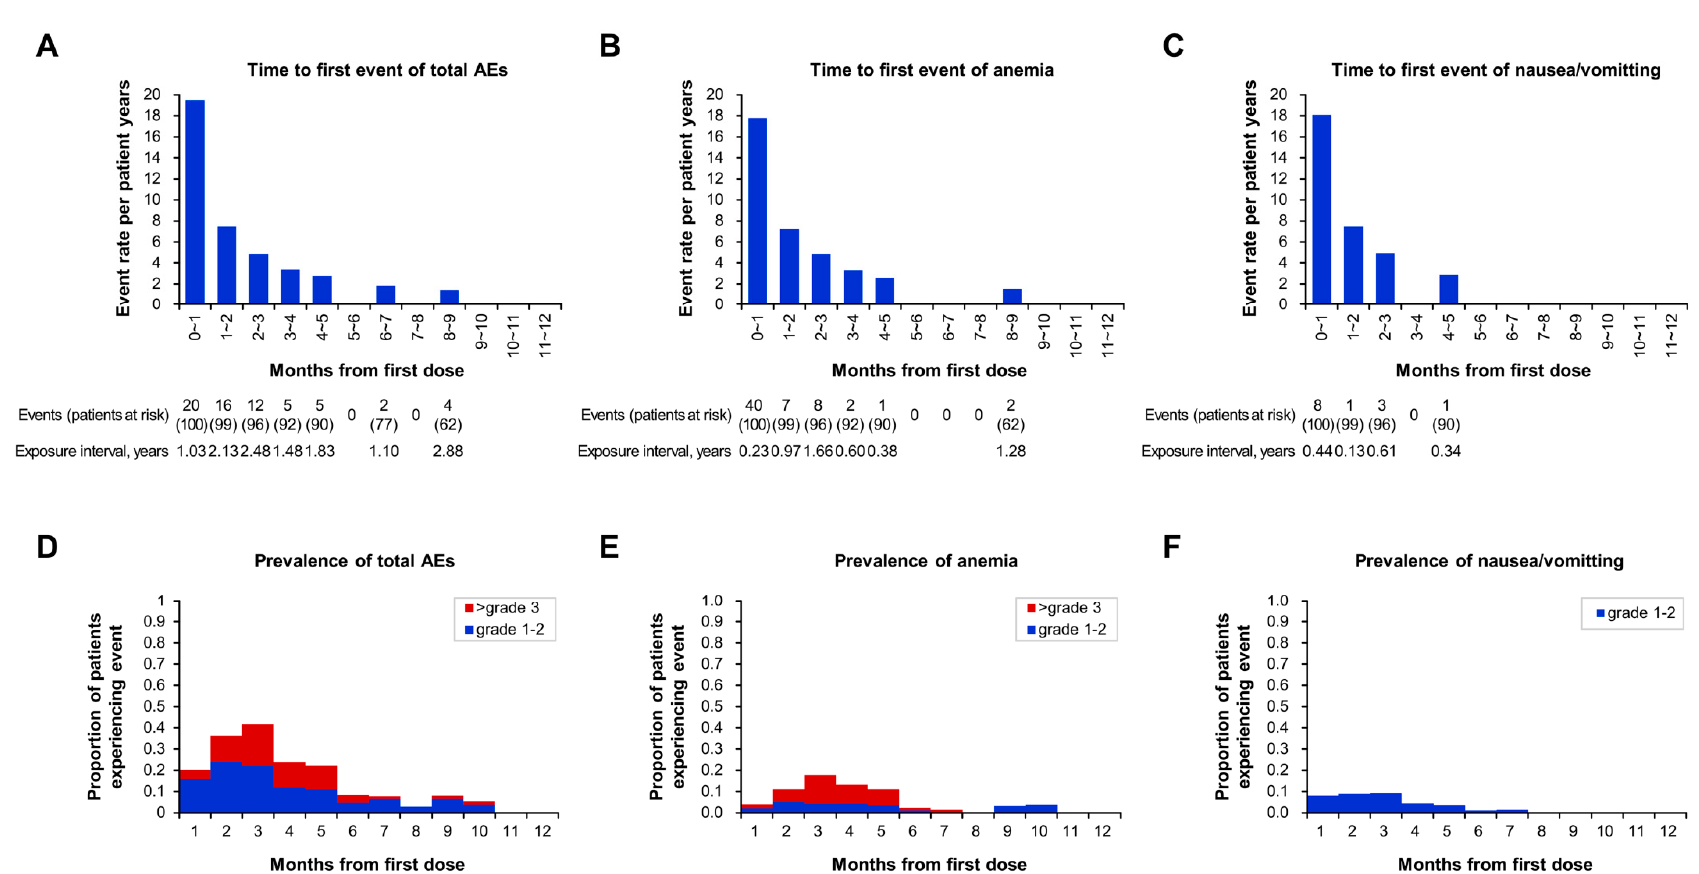
Figure 2. Characteristics of adverse events (AEs): time to first event (event rate = number of first events/exposure during time interval), (A) total AEs, (B) anemia, and (C) nausea/vomiting and prevalence by month and grade of (D) total AE, (E) anemia, and (F) nausea/vomiting in olaparib-treated patients.